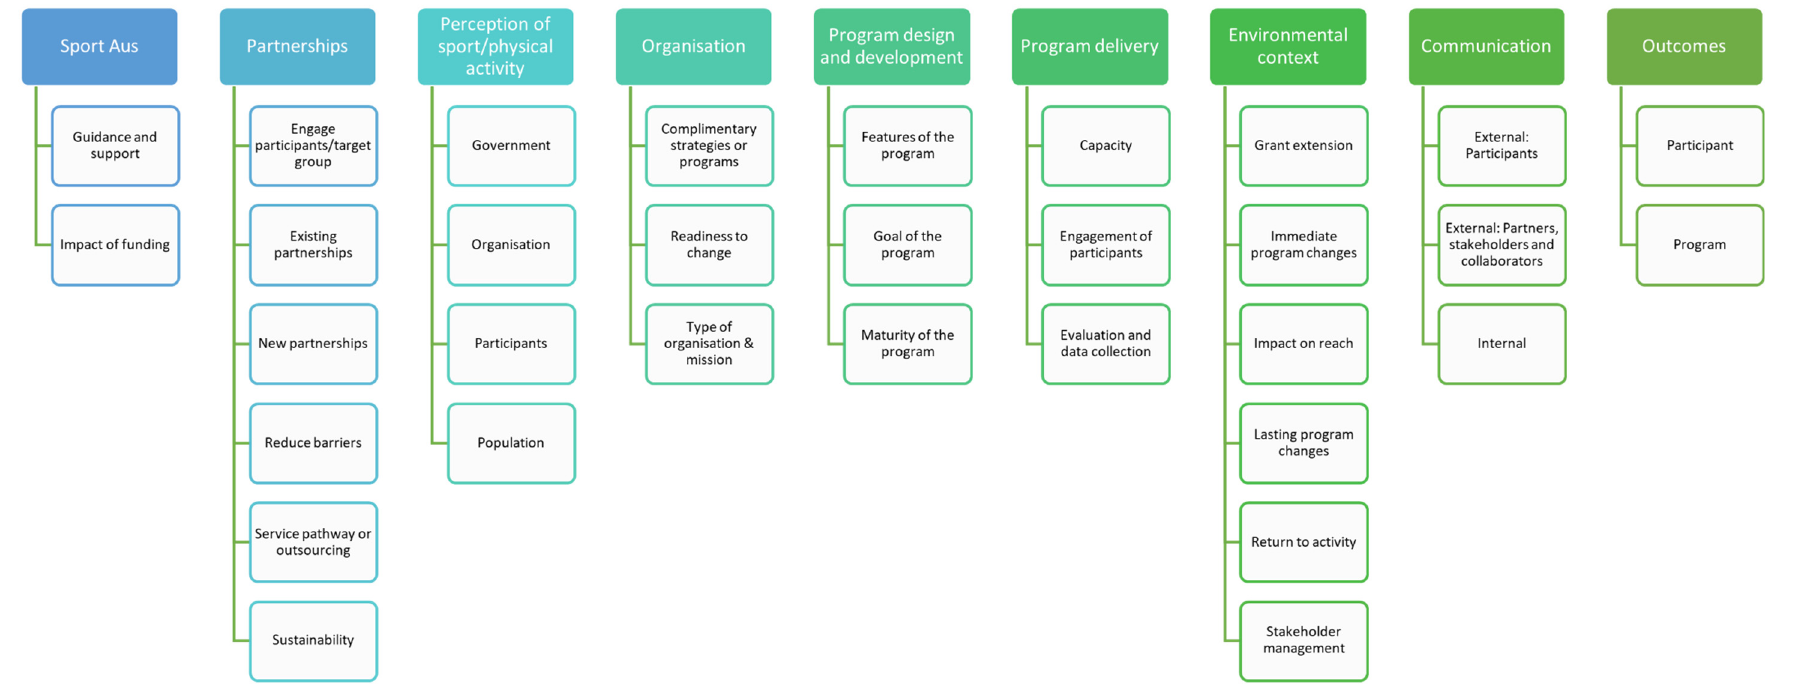
Figure 1. A thematic scheme of the codes and sub-codes identified within the qualitative interview